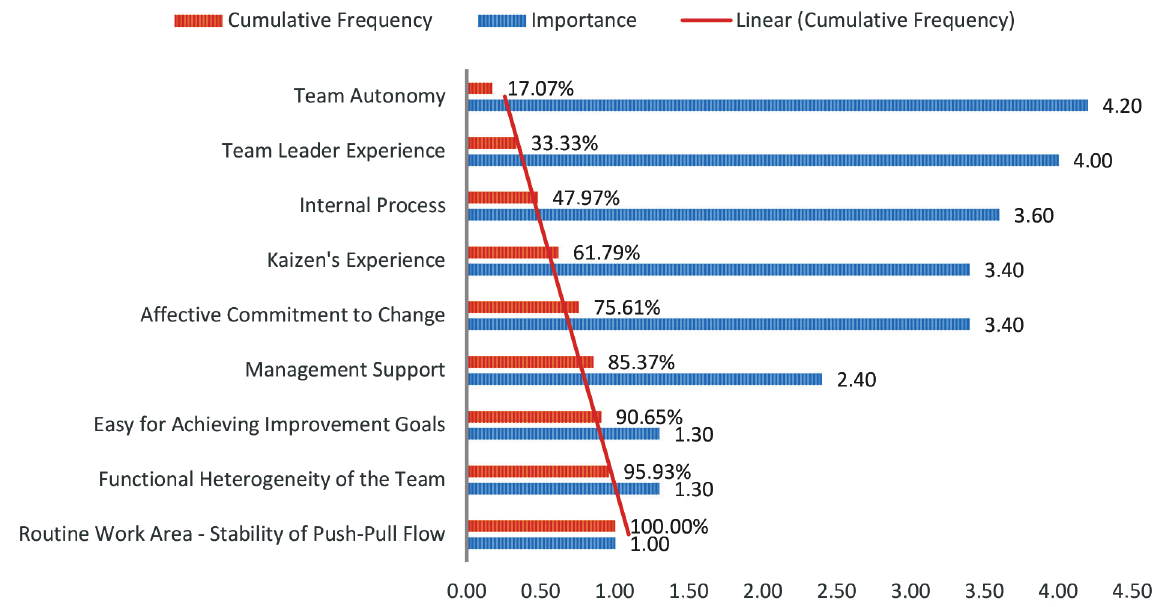
Figure 8. Most relevant capacity of team to achieve